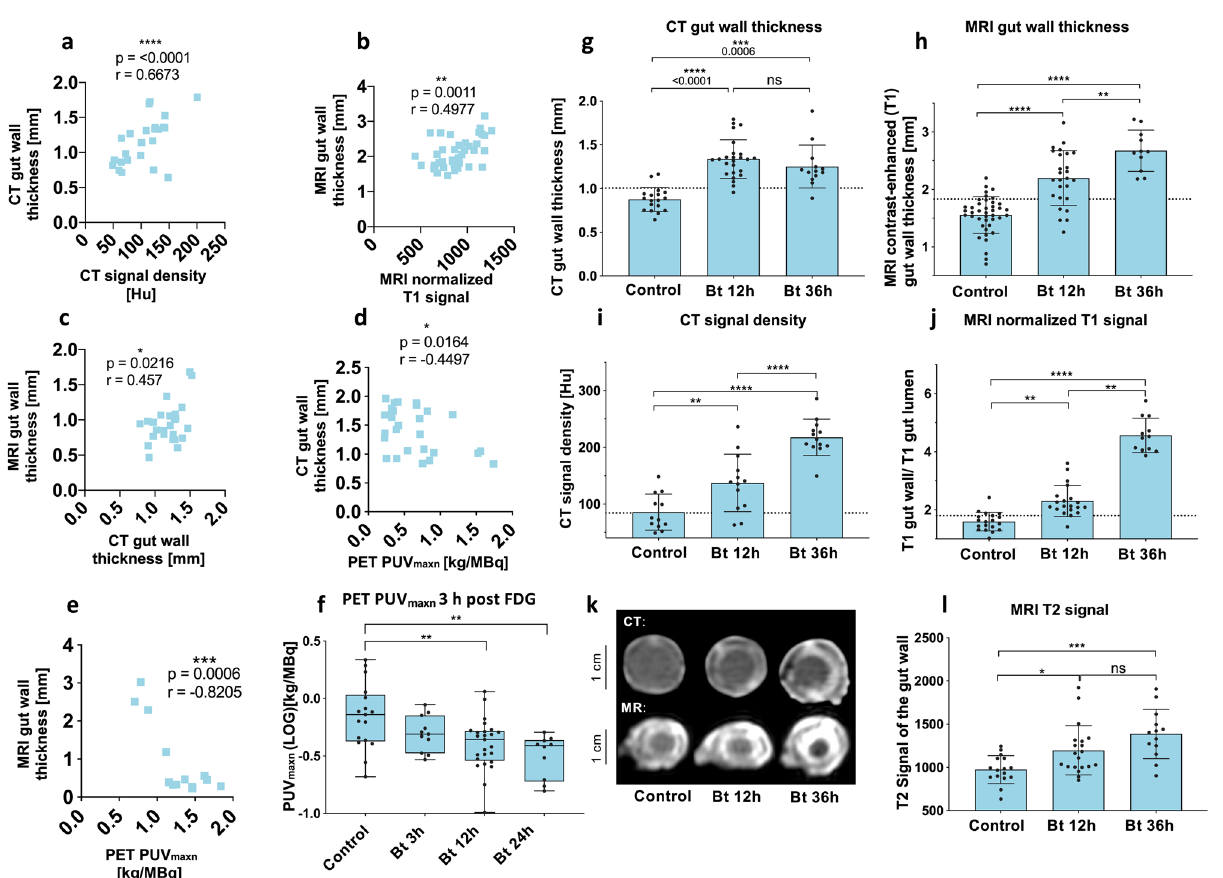
overall treatment-speci fi c mean thickness, preferred model: different curve for each data set, F (3, 301)=391, P <0.0001). Contrast-enhanced CT and MRI gut wall thickness showed a gentamicin concentration-dependent reduction of gut wall thickness in animals fed with Bt and two different gentamicin concentrations ( e ): n =59, one-way ANOVA, F (3,55)=15.83, R 2 =0.4634, P <0.0001, ( f ): n =83, Kruskal- Wallis-test=28.07, P <0.0001. This fi nding was also con fi rmed by the differential survival of the treated animals ( g ). Dashed lines indicate threshold values. Sig- ni fi cance levels: ns= P >0.05, * P ≤ 0.05, ** P ≤ 0.01, *** P ≤ 0.001 and **** P ≤ 0.0001. Survival kinetics shows the sum of the conducted experiments. Bar charts repre- sent mean and SD. Every data point represents a single animal. Source data are provided as a Source Data fi le.